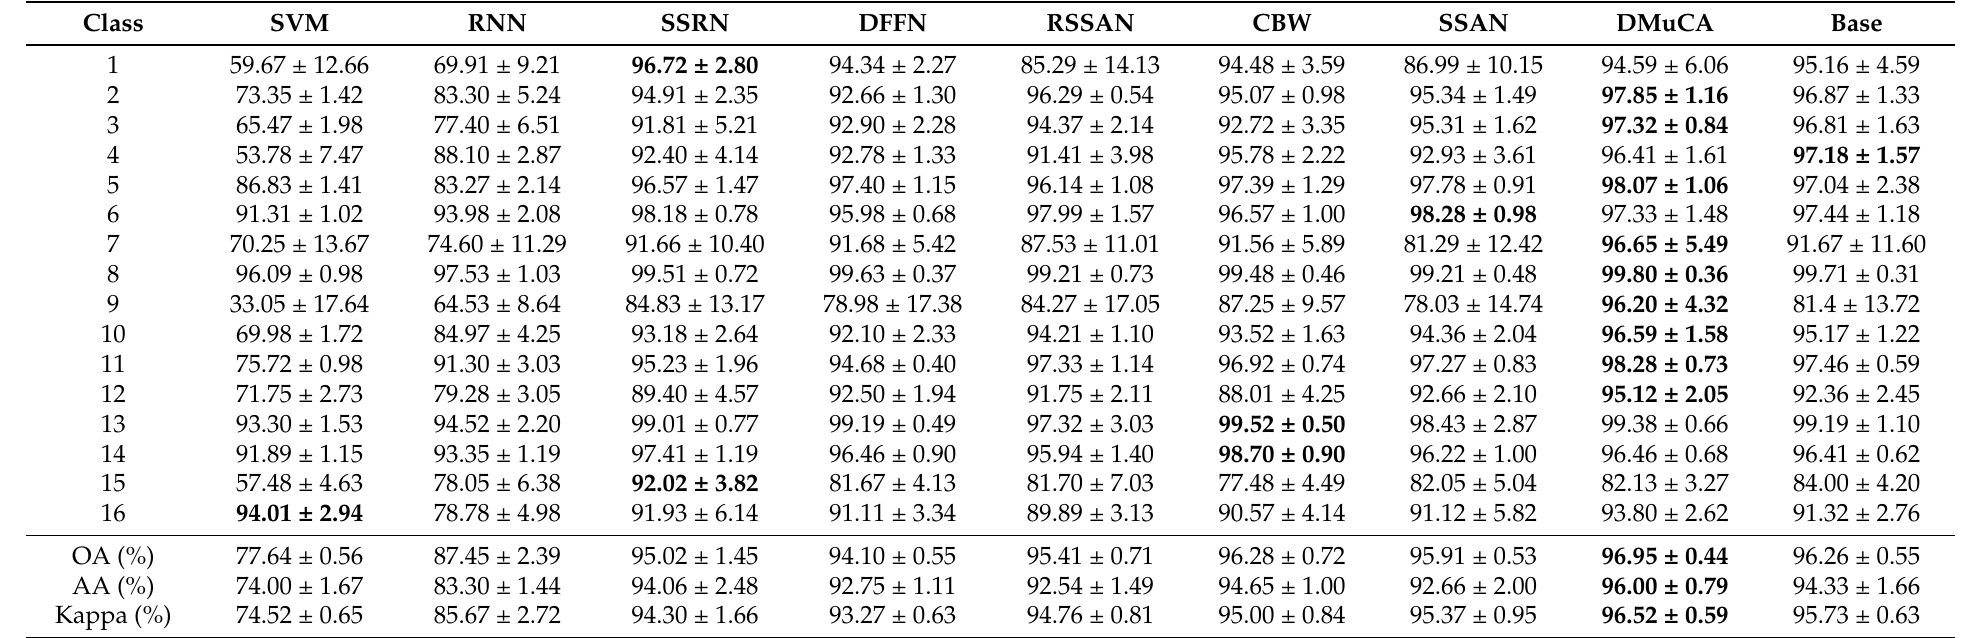
Table 10. Testing results over IN dataset with 10% samples per class for model training. The best results are highlighted in bold